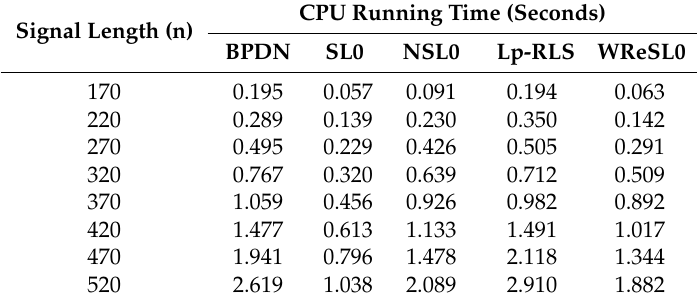
Table 2. Signal CPU running time (CRT) analysis for BPDN, SL0, NSL0, L p -RLS, and the proposed WReSL0 with signal length changes according to the sequence [170,220,270,320,370,420,470,520] when δ N = 0.2.